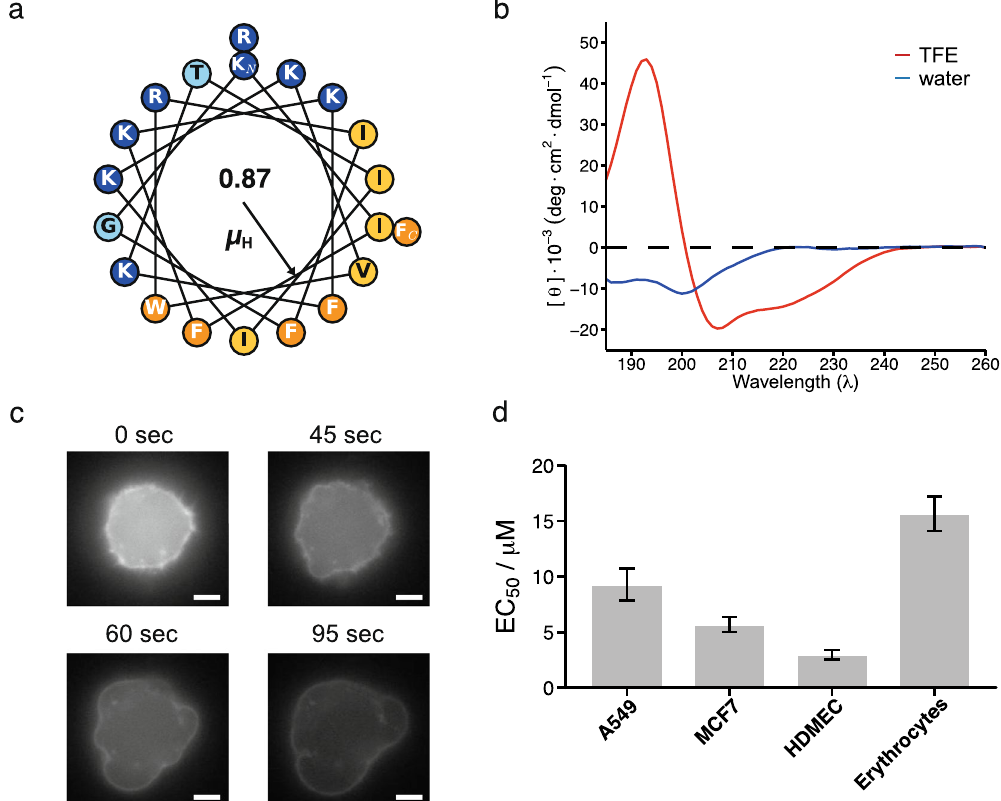
Figure 1. Characterization of the AmphiArc2 peptide. ( a ) Helical wheel plot of the peptide sequence with annotated hydrophobic moment direction and magnitude ( µ H ). Polar residues are shown in light blue, positively charged residues in dark blue, hydrophobic residues in yellow, and aromatic residues in orange. ( b ) Circular dichroism spectra of the peptide in water (blue) and in a 50% v/v TFE:water solution (red). ( c ) Time sequence of cell death of a single MCF7 cell trapped in a microfluidic chamber after exposure to the AmphiArc2 peptide. The cells were fluorescently labeled with calcein-AM dye in the cytosol, and their membrane was stained with fluorescently labeled EpCAM antibody. The scale bar represents 10 µ m. ( d ) EC 50 values of the peptide activity against the A549 and MCF7 cancer cells, noncancer HDMEC primary cells and the hemolytic activity (HC 50 ) value of the peptide activity against human erythrocytes are shown. Error bars show the standard deviation of N = 3 independent